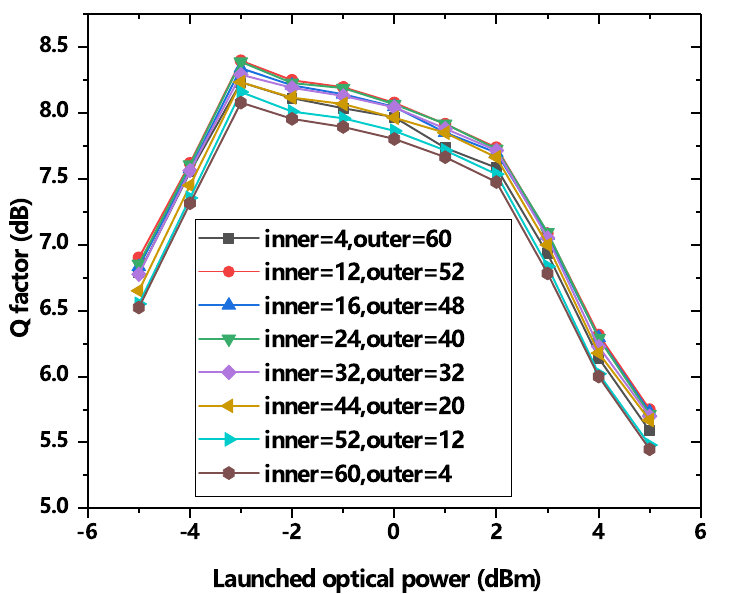
Figure 5. The process of the CS M-ary SVM NLE scheme.